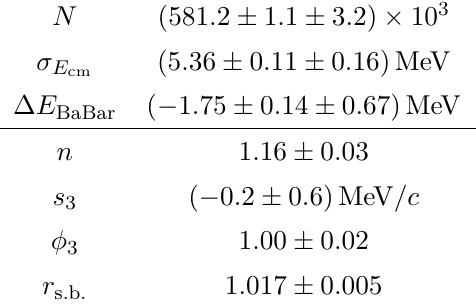
Table 2 . Results of the simultaneous fit to the Belle M bc distribution and the BaBar cross section scan results [1]. The first error is statistical, the second one (if present) is